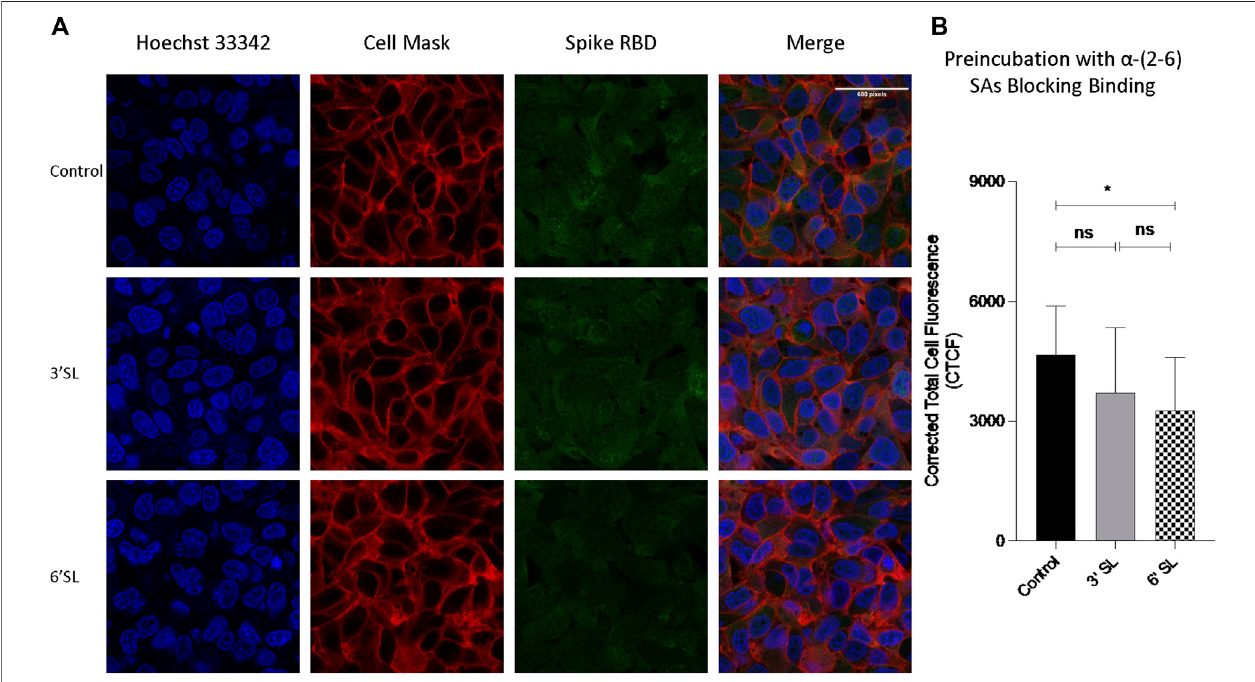
FIGURE6| SialylatedHMOsdiminished bindingofspikeproteinRBDtoHepG2Cells.Fluorescentlabelledproteinswerepreincubatedwith1 mgperml3 ′ -FL(3 ′ - sialyllactose) and 6 ′ -SL (6 ′ -sialyllactose) respectively at room temperature. (A) Immuno fl uorescence for S protein RBD binding with cells. The columns (from left to right) show staining of nuclear acid (Hoechst 33342), plasma membrane (CellMask ™ Deep Red), S protein RBD, and merged image. Scale bar, 600 pixels. (B) Quanti fi cation of fl uorescent intensity of spike protein RBD binding. Fluorescence intensity was quanti fi ed for selected cell area. Quanti fi cation was performed with software ImageJ. Asterisks indicate the statistical signi fi cance between groups compared (* p < 0.05%; ns p <